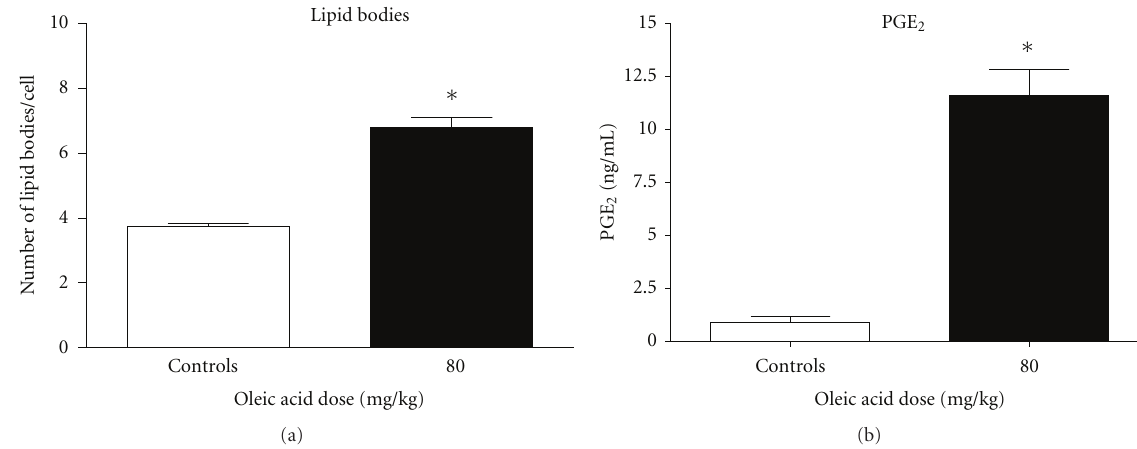
Figure 3: Lipid body formation and prostaglandin production in BALF after intravenous OLA injections. BALF were collected 24h after injections of the 80mg/kg dose. Each bar represents the mean ± SEM of lipid bodies per cell in 50 consecutively counted cells from 6 di ff erent animals. PGE 2 quantification is the mean ± SEM of 3 independent experiments. ∗ P < 0 . 05.